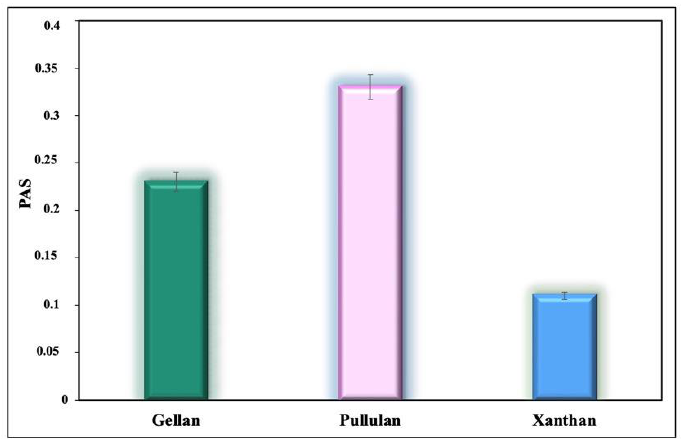
Figure 2. Prebiotic activity score (PAS) of the microbial polysaccharides. Significant difference ( p < 0.05) was found with different polysaccharides. The PAS values were calculated after 24 h of cultivation. The PAS indicates the ability